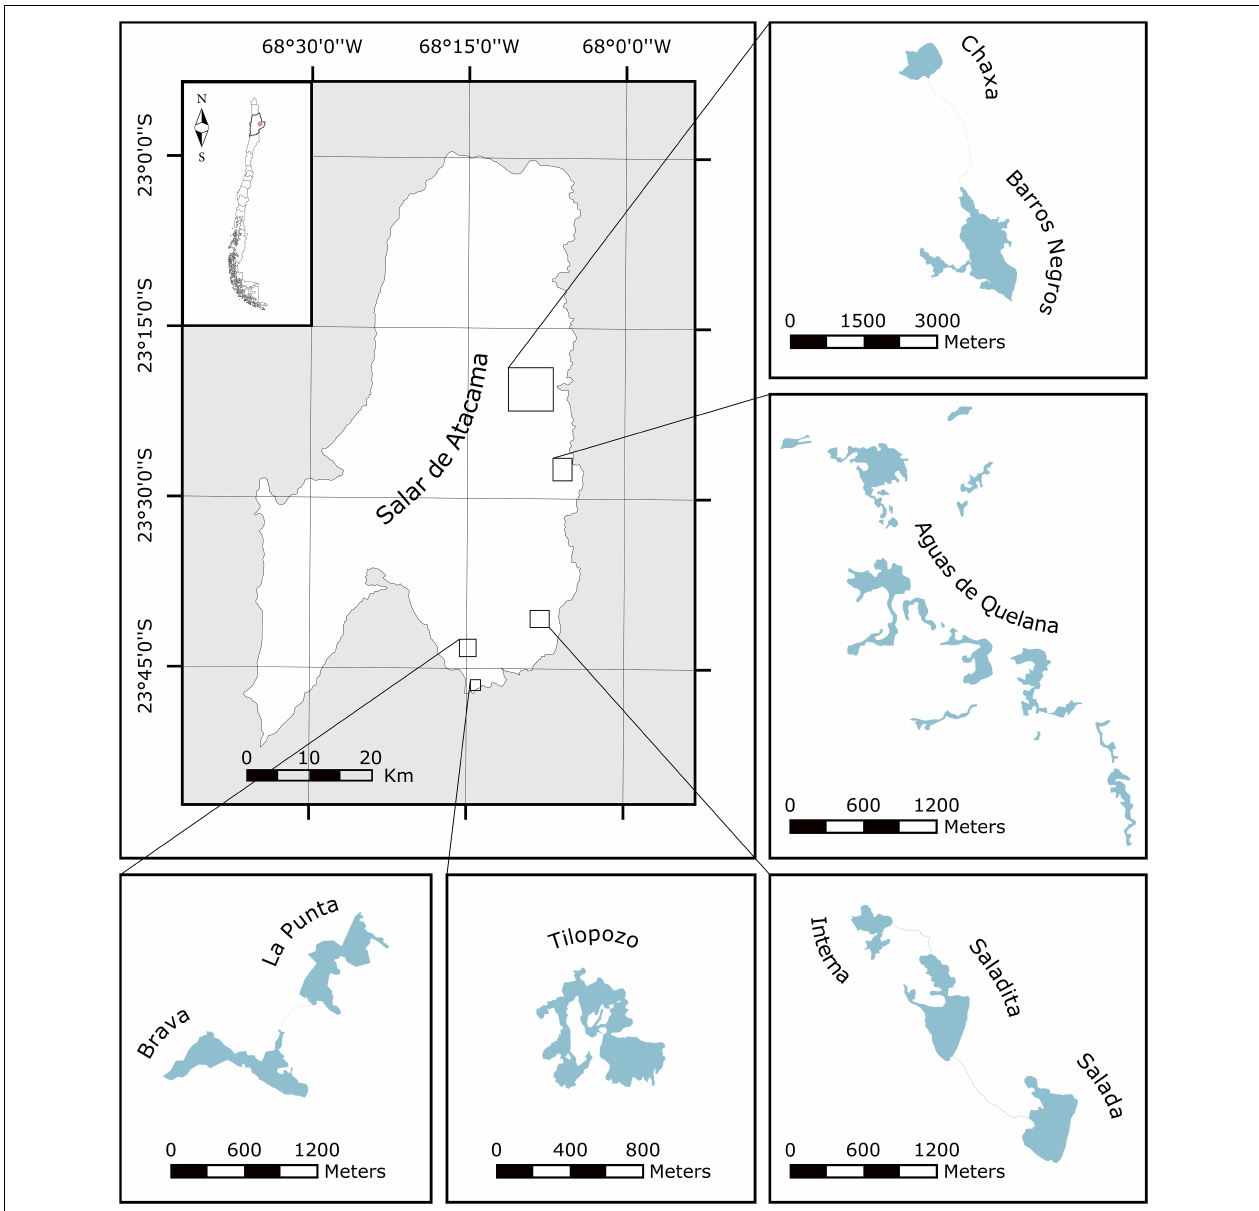
FIGURE 1 | Location of the study area which consists of a system of several lakes and wetlands. The eight lakes and wetlands of this study are outlined in the five respective